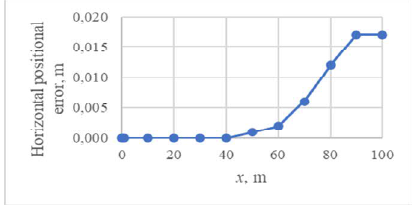
Figure 14 . The example of dependence between a horizontal positional error on a road sign and x value when density of